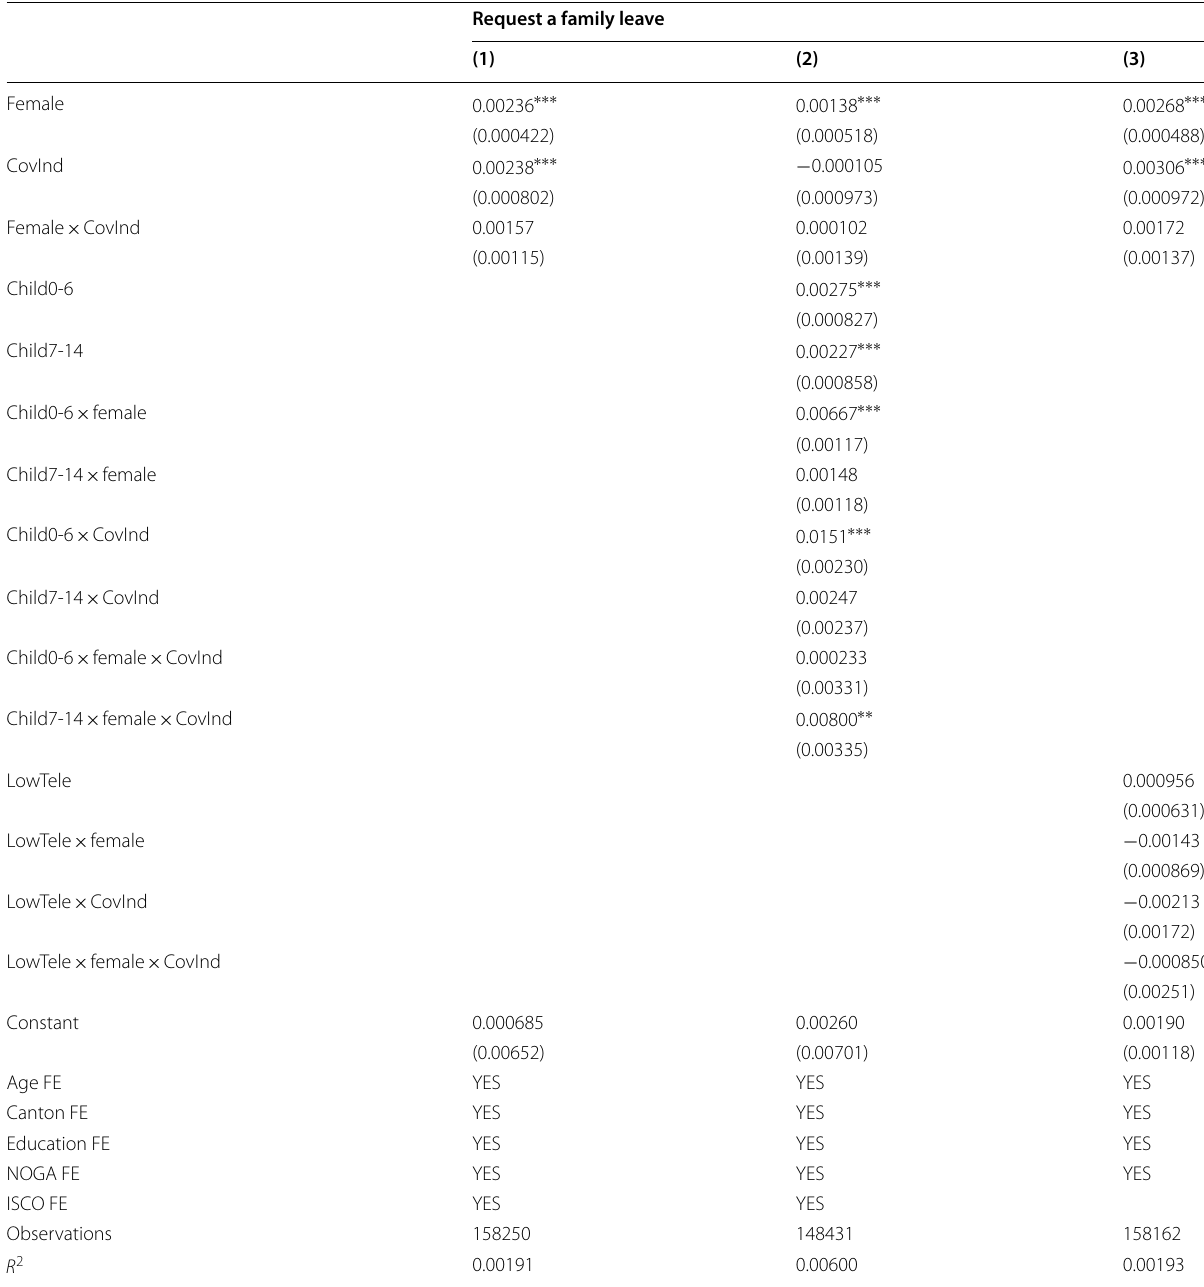
Table 19 The effect of COVID-19 and gender on family